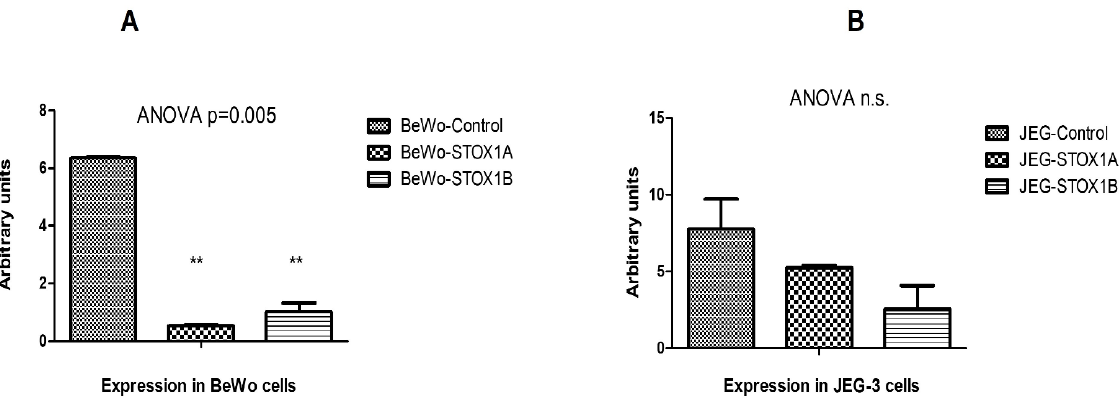
Figure 1. Downregulation of CD24 expression in ( A ) BeWo and ( B ) JEG-3 cells overexpressing STOX1-A and STOX1-B variants. The qPCR experiments were conducted in duplicates using, as a normalizer, the geometric average of the ∆ CT of the two reference genes (HPRT and YWHAZ). The error bars are SEM. The two asterisks in A represent the individual one-way ANOVA significant level of each STOX1 variant compared to the control (** p < 0.01). The lower degree of downregulation of CD24 in the JEG-3 vs. BeWo cells could be due to the different origins and features of these two placental-derived cell lines. ∆∆ CT The 2 − of CD24 expression is presented for the cell line overexpressing STOX1-A/B relative to the mock empty control vector (100%), all standardized against the housekeeping genes HPRT and YWHAZ; A—BeWo cells, B—JEG-3 cells. The analysis used